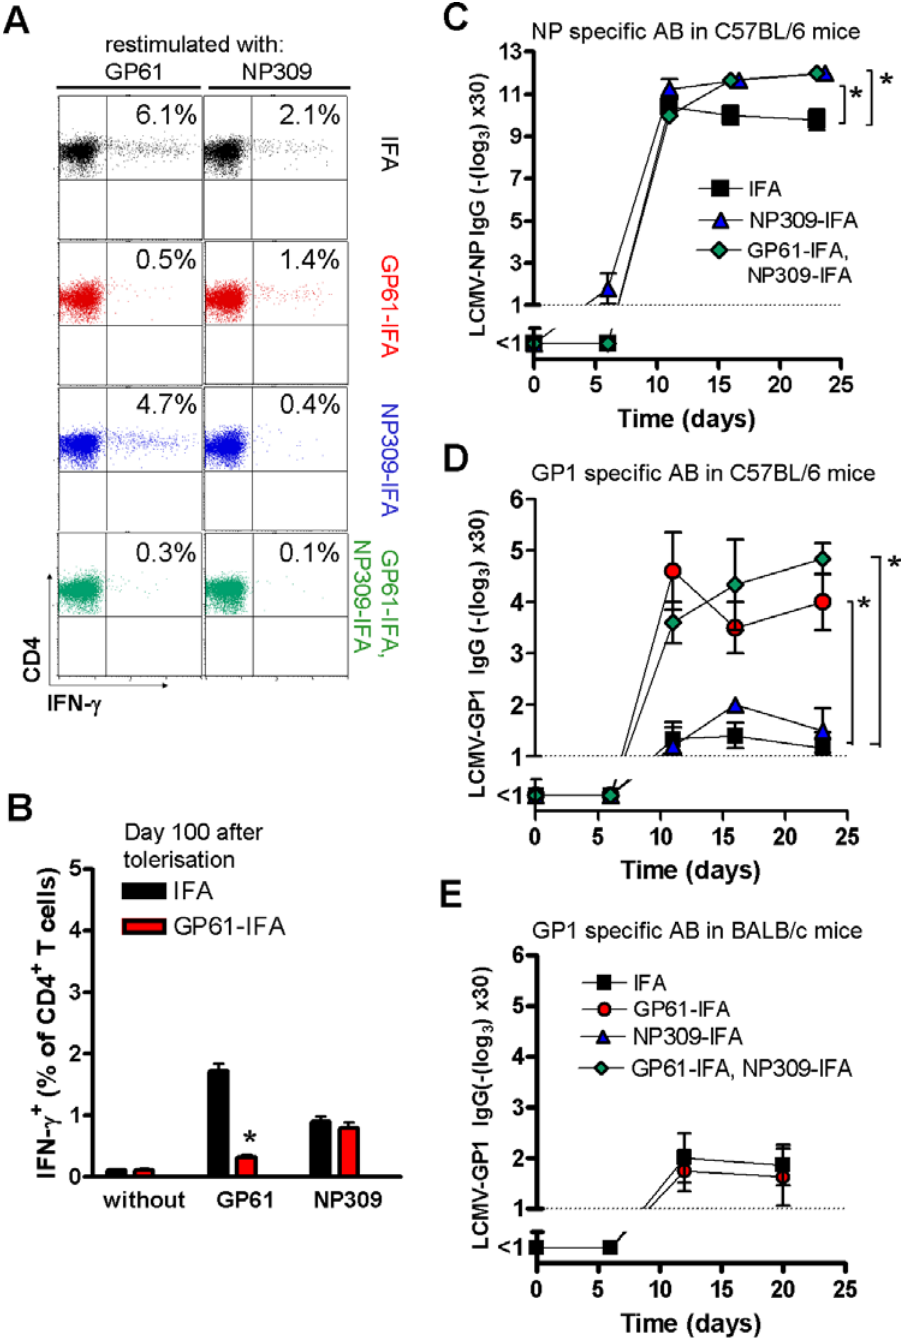
Figure 2. Tolerisation of CD4 + T cells improves LCMV-specific antibody response. A: C57BL/6 mice were tolerised with either 100 m g GP61-80-IFA, 100 m g NP309-328-IFA, or both peptides in IFA on days -109, -106, -103. On day 0, mice were infected with 200pfu LCMV-WE and splenocytes were analysed for intracellular IFN- c expression after re-stimulation with different T cell epitopes in vitro 12 days later. The original dot plots are shown (n=5). B: C57BL/6 mice were treated with 100 m g GP61-80-IFA or IFA on days -9, -6 and -3. On day 0, mice were infected with 200pfu LCMV-WE and splenocytes were analysed for intracellular IFN- c after re-stimulation with different T cell epitopes in vitro 12 days later (n=3, p , 0.001). C + D: C57BL/6 mice were tolerized with either 100 m g GP61-80-IFA, 100 m g NP309-328-IFA or both peptides in IFA on days -9, -6, -3. On day 0, mice were infected with 200pfu LCMV-WE and LCMV-nucleoprotein (NP) specific antibodies were measured by ELISA at the indicated time points (n=5, * p , 0.05, C). LCMV-glycoprotein (GP) specific antibodies were measured by ELISA at the indicated time points (n=5–7, *p , 0.001, D). E: BALB/c mice were peptide-tolerised with 100 m g GP61-80-IFA or IFA alone on day -9, -6 and -3. On day 0 mice were infected with 200pfu of LCMV-WE and LCMV-GP specific IgG antibodies were measured in the serum at the indicated time points (n=8, ns).